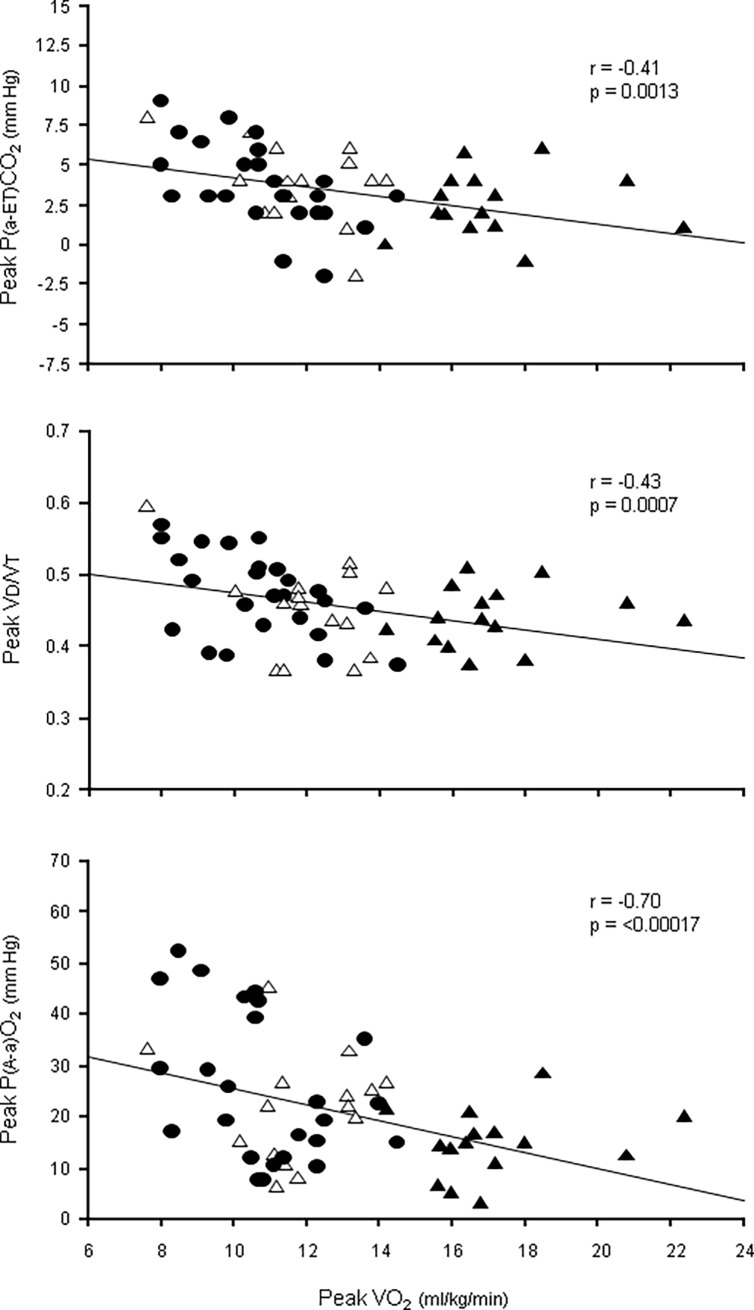
Peak arterial-end-tidal PCO2 difference, physiological dead space-tidal volume ratio and alveolar-arterial PO2 difference as a function of peak VO2 in the study population.The prevalence of high peak P(a-ET)CO2 and peak VD/VT values in the 3 study groups testify to a trend toward high ventilation/perfusion ratio mismatch in the whole study population. Full circles, empty triangles and full triangles are LVAD, HFrEF-matched and HFrEF≥14, respectively. P(a-ET)CO2 = arterial-end-tidal PCO2 difference; VD/VT = physiological dead space-tidal volume ratio; P(A-a)O2 = alveolar-arterial PO2 difference.